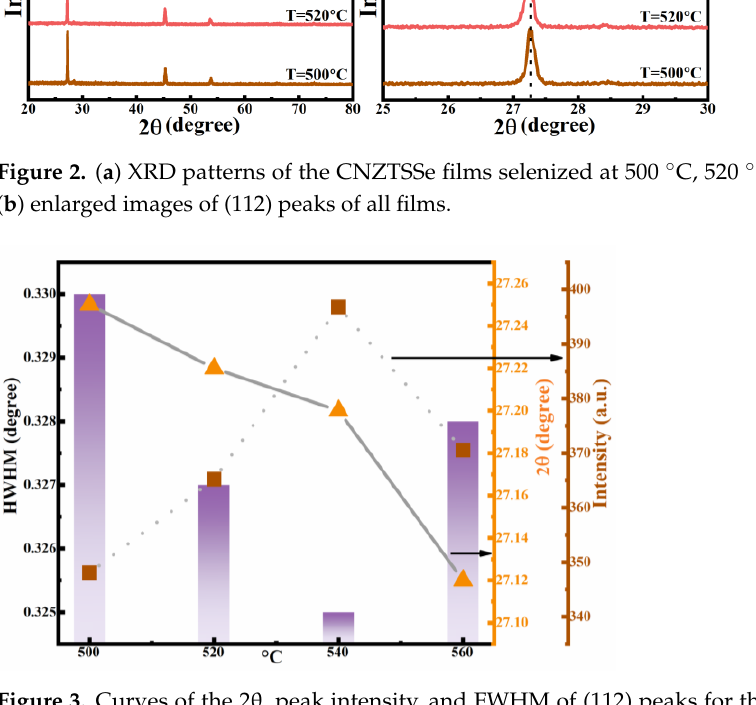
Figure 3. Curves of the 2 θ , peak intensity, and FWHM of (112) peaks for the CNZTSSe films as a function of selenization temperature.